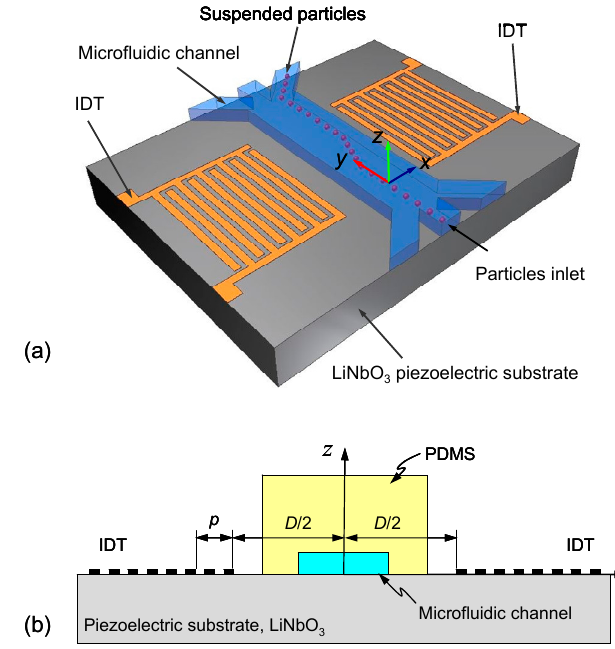
Figure 1. ( a ) Configuration of a standing surface acoustic wave (SSAW)-based acoustofluidic device with single-pitch interdigital transducers (IDTs) and ( b ) the cross-section model for the numerical simulations (illustrating the symmetric structure). The device consists of a microfluidic channel with three inlets and three outlets bonded to a piezoelectric substrate patterned with two IDTs. Suspended particles in the channel can be manipulated to exit through a specific outlet.